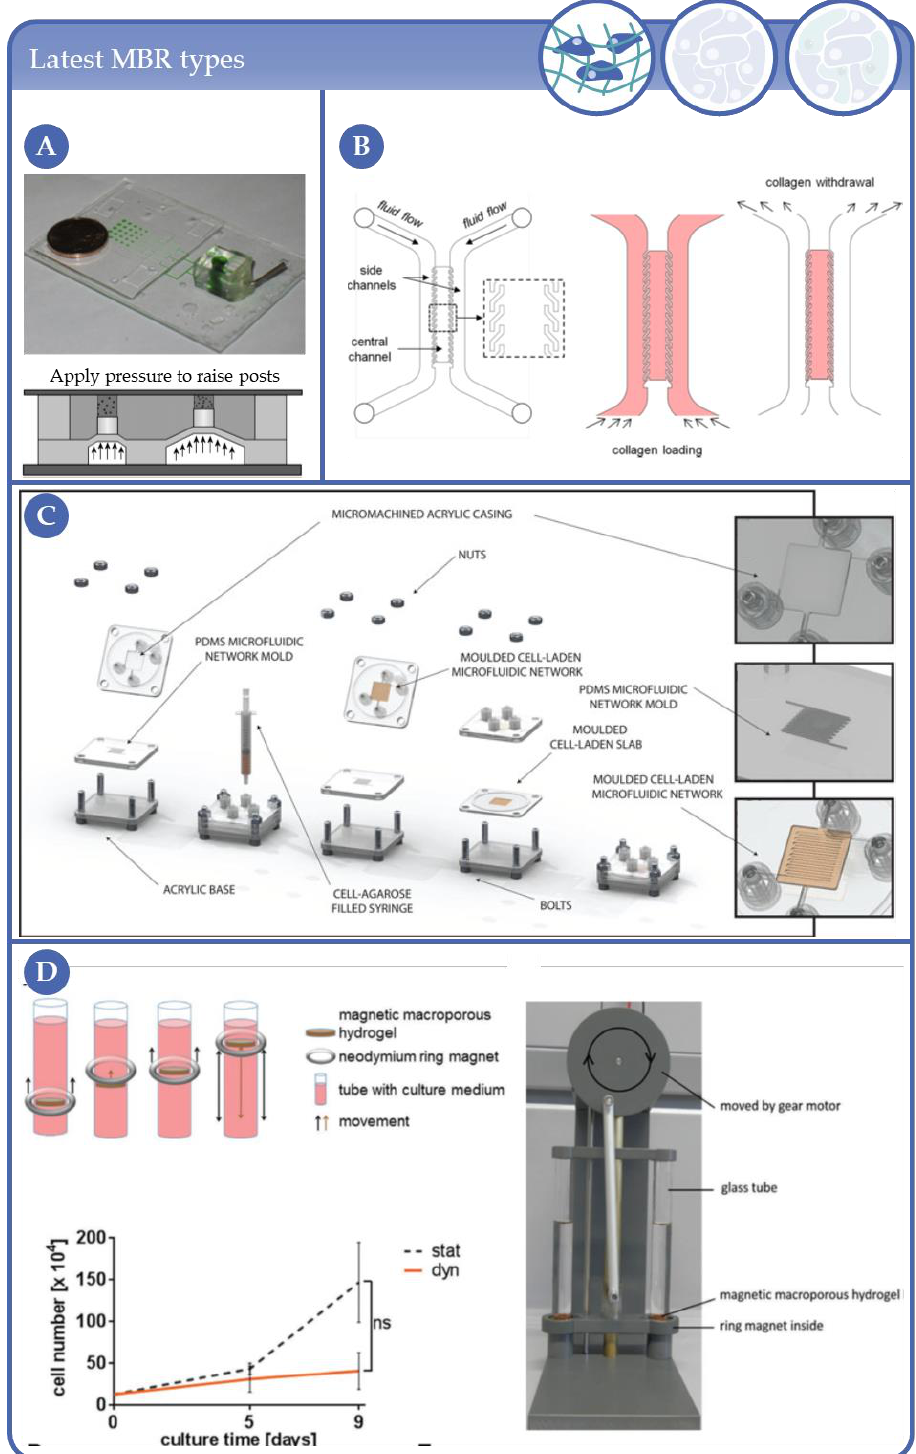
Figure 7. Latest MBR types and approaches. ( A ) Miniaturized MBR for mechanical compressive loading of cells in hydrogels; reprinted from [35] with permission from Springer Nature. ( B ) MBR with channels divided by an array of S-shaped micropillars which allow the formation and maintenance of molecule gradients for chemotaxis experiments; reprinted from [37] with permission of AIP Publishing. ( C ) MBR with microfluidic networks in cell laden gels casted between an acrylic casing and a PDMS mold for active perfusion to generate thick and robust tissue engineering(TE)-constructs; reprinted from [36] with permission of John Wiley and Sons. ( D ) MBR with magnetic cell-laden hydrogels for contactless movement of the gel-based constructs by an external magnetic field; Reprinted from [39] with permission of John Wiley and